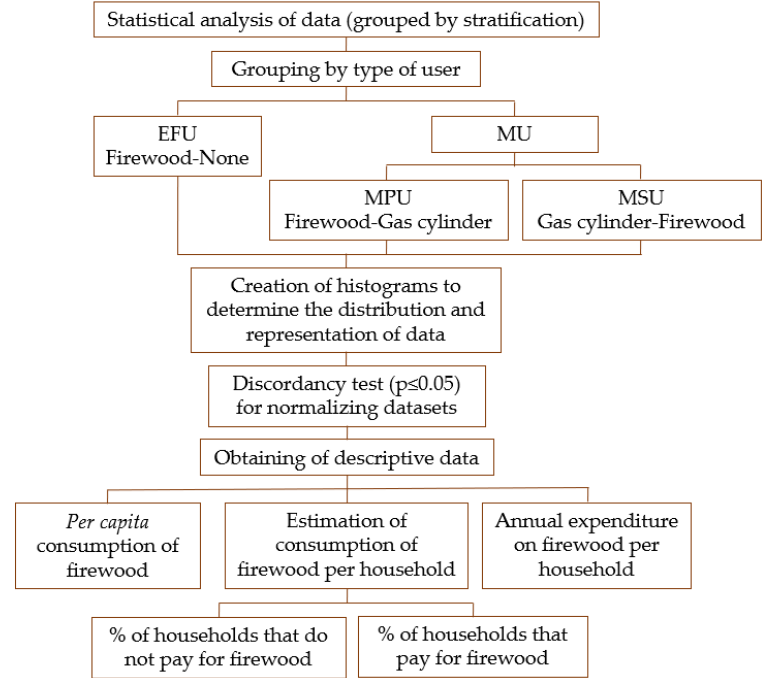
Figure 2. Statistical treatment of information for determining annual consumption of firewood per household, and expenditures for firewood. Source: Own elaboration.